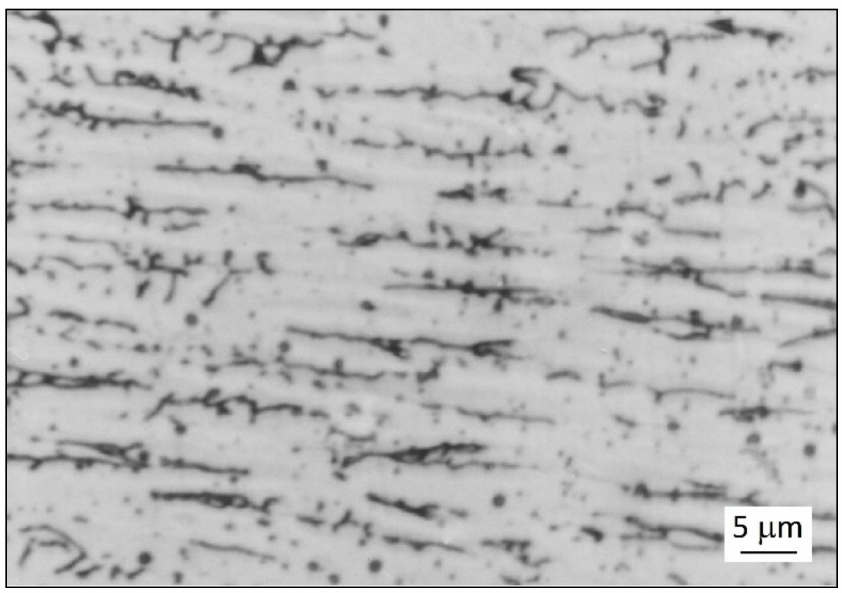
Figure 7. Detail of the FZ morphology (amplification power 500 ×